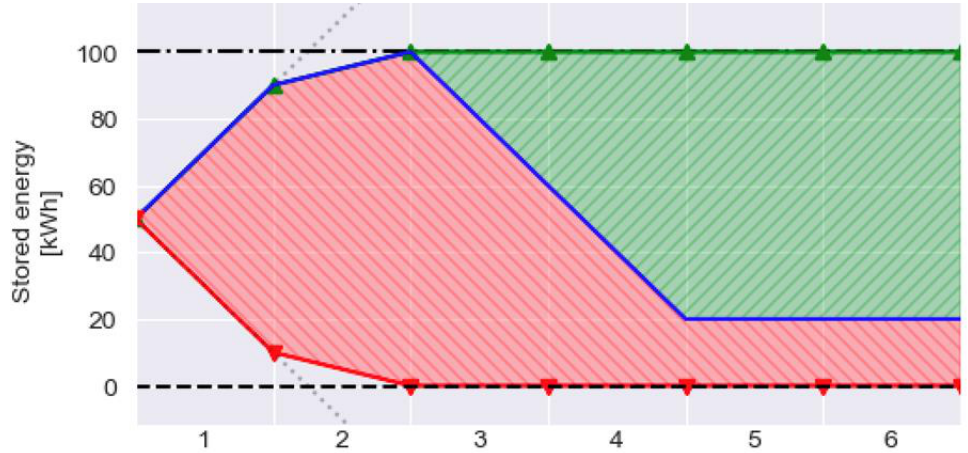
Figure 5. Illustration of baseline and energy content development. Table 4. Bids for iteration